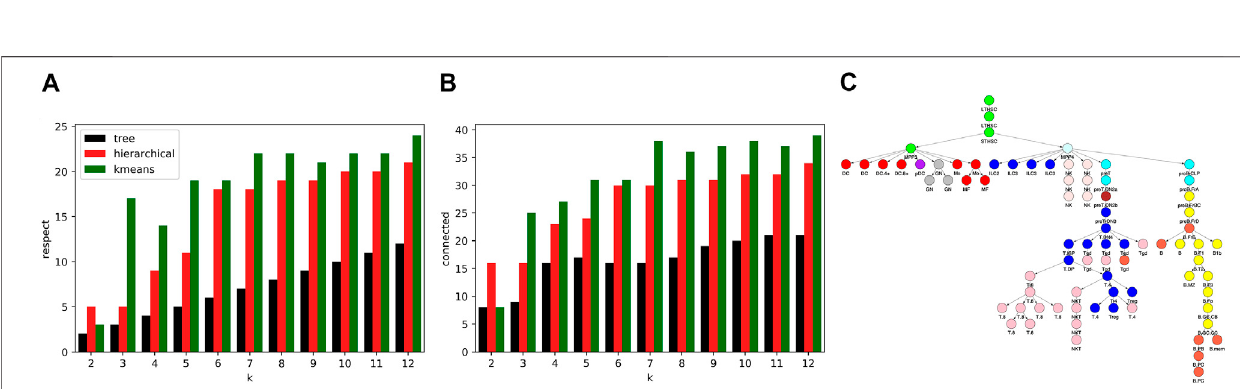
FIGURE6| Decompositionofaccessibilityvariation.UsinganANOVAanalysis,wecalculatedanR-squaredvaluegivingthefractionof (A) totalvariationand (B) cell type associated variation in M captured by our co-clustered approximation matrices ~ M hierarchical and k-means methods without taking the differentiation tree into account.